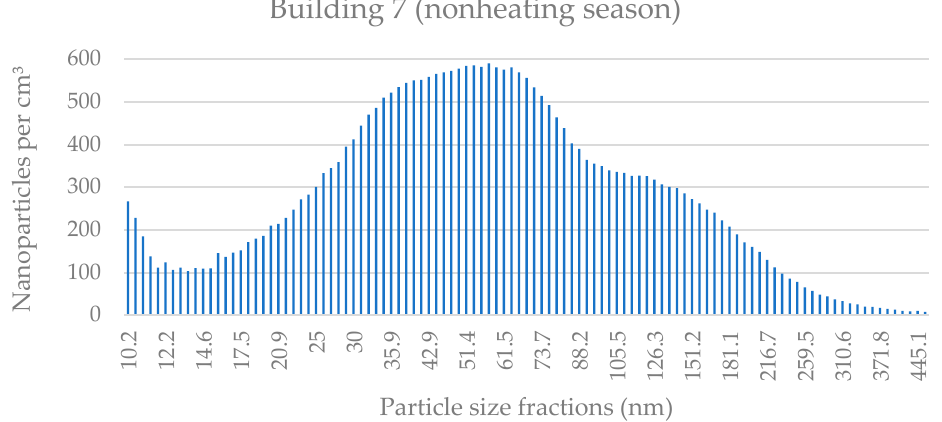
Figure A13. The average nanoparticle concentration in each size fraction in Building 7 during a one- week measurement period during the heating season.